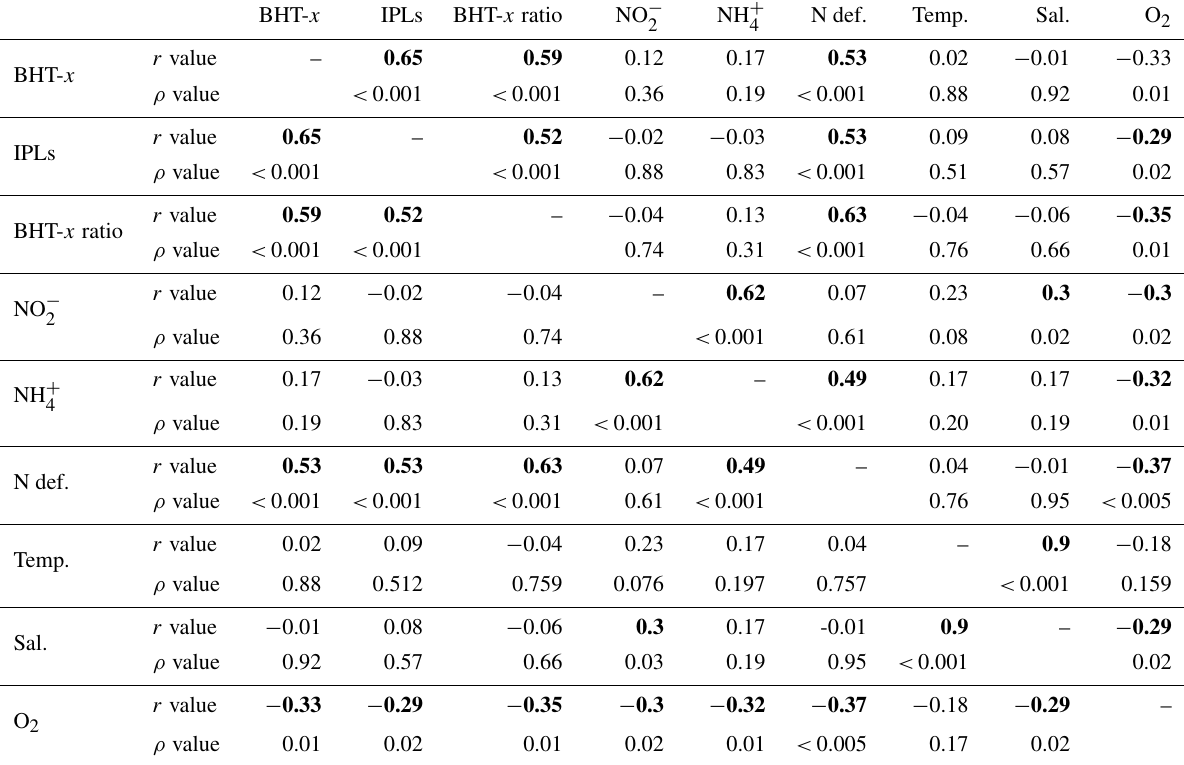
Table 2. Pearson’s correlation matrix between BHT- x , oxygen (O 2 ), ammonium (NH + deficiency (N def.), temperature (Temp), salinity (Sal) and BHT- x . r values indicate Pearson’s correlation coefficient. p values indicate the significance level (two-tailed), with bold numbers indicating that correlation is significant at the 0.05 significance